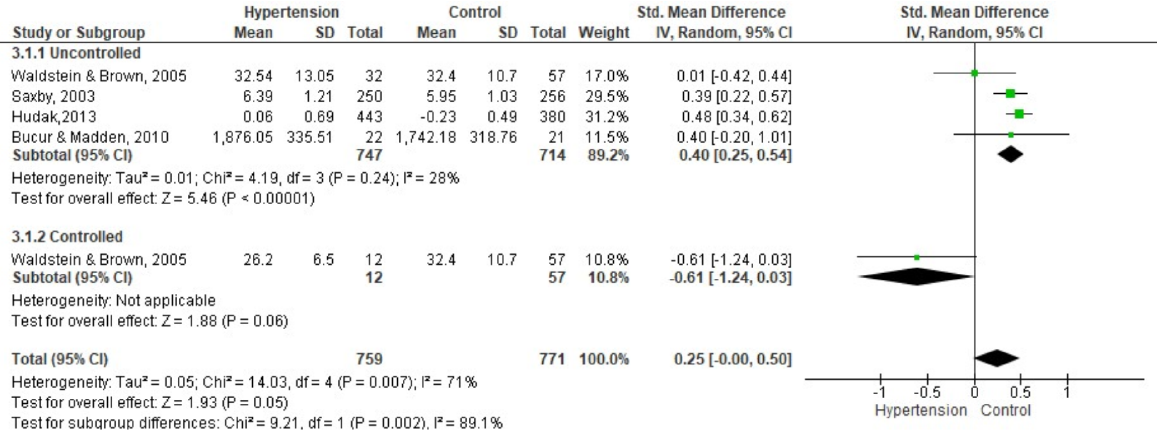
Figure 2. Meta-analysis on the comparison of groups with controlled and uncontrolled hypertension between the control group in processing speed. High score indicates lower performance.